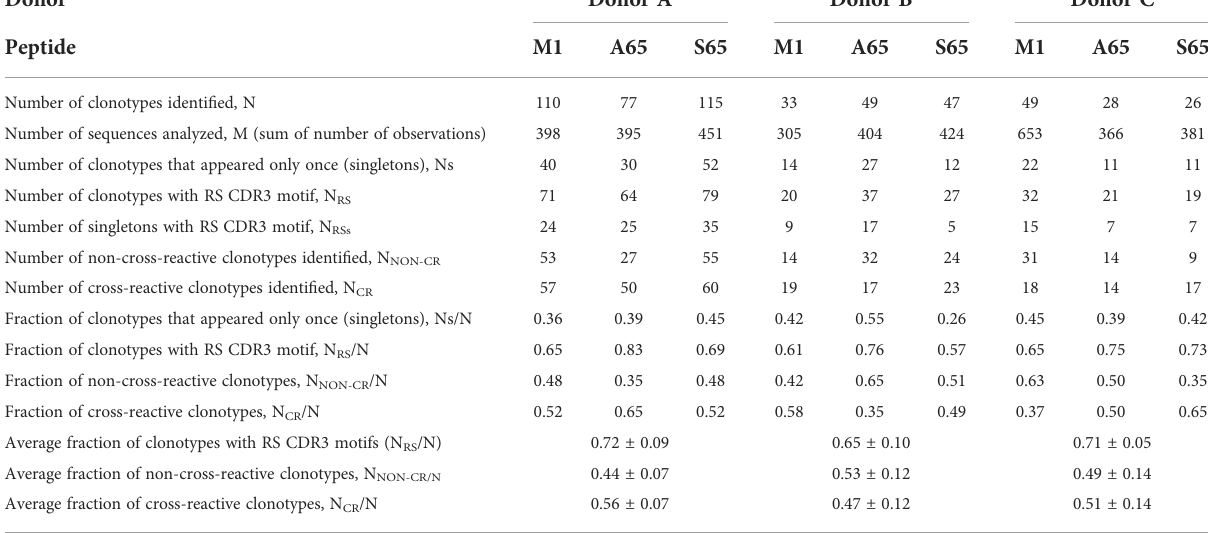
TABLE 1 Repertoire characteristics and summaries for M1 58-66 and substituted peptides for three